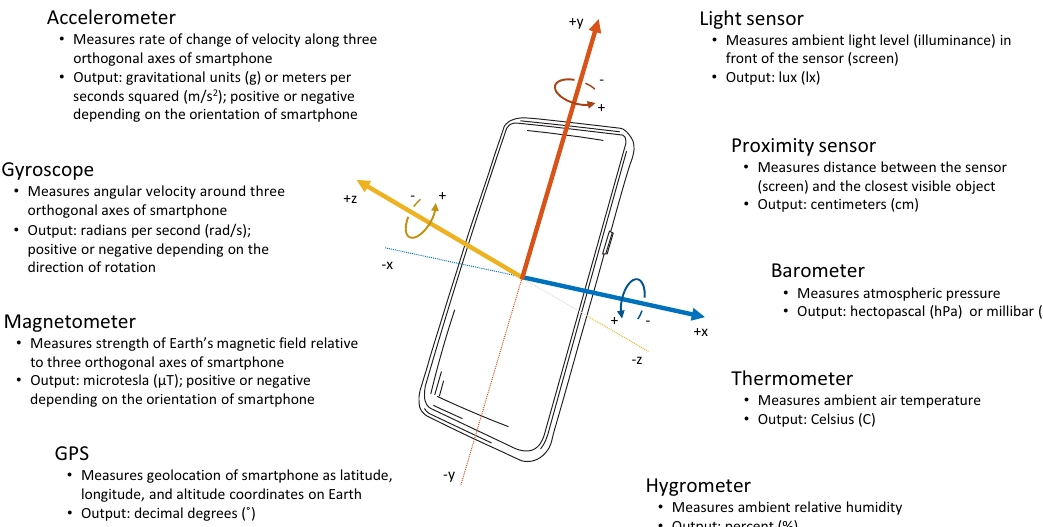
Fig. 6 Overview of standard smartphone sensors. Inertial sensors (accelerometer, gyroscope, and magnetometer) provide measurements with respect to the three orthogonal axes ( x , y , z ) of the body of the phone; the remaining sensors are orientation-invariant.